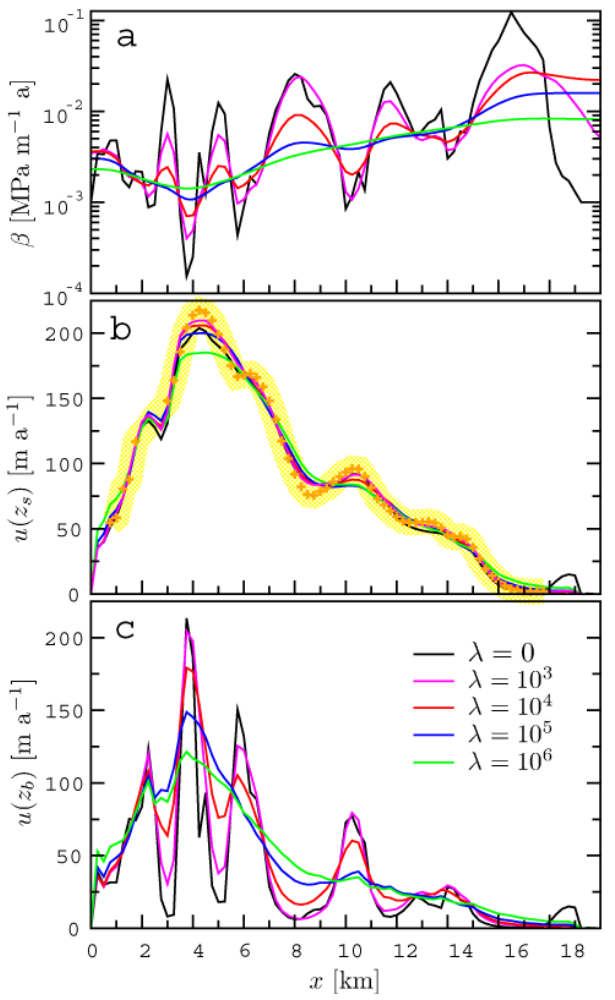
Fig. 2. Sensitivity of the results to the regularisation penalisation λ for the 1978 summer data. (a) Distribution of the inferred basal friction parameter β along the central flow line and correspond- ing (b) modelled and measured (orange cross) surface velocities and (c) modelled basal velocities. The yellow band represents the ± 10ma − 1 error on the velocity measurements estimated by Ray- mond and Harrison (1988).